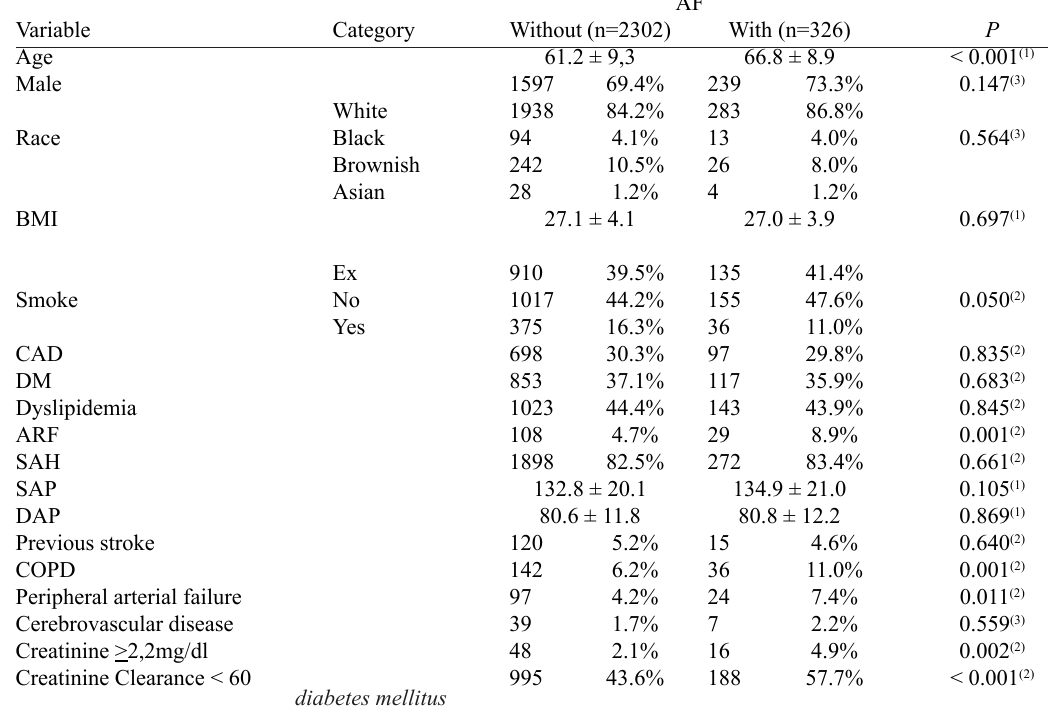
Table 1. Descriptive values of demographic variables, procedure and preoperative risk factors, according to the AF